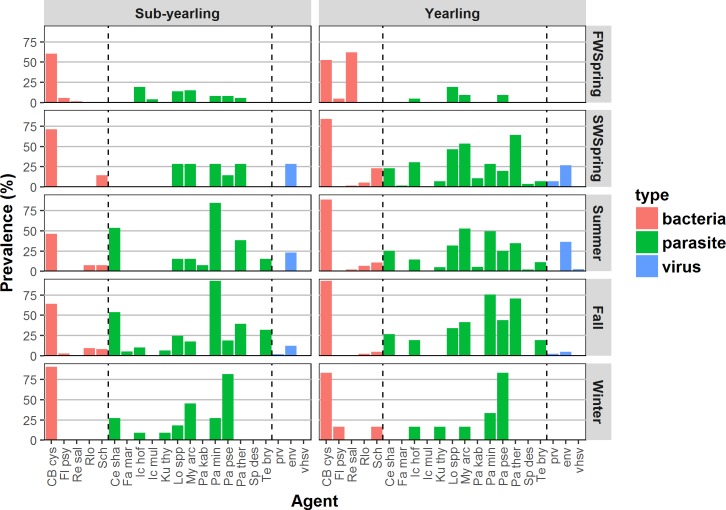
Seasonal prevalence of infectious agents in sub-yearling and yearling juvenile Chinook salmon from the Fraser River.Sample sizes are provided in Table 1; full names are provided in S1 Table. Infectious agents are separated into type (bacteria, parasite and virus).